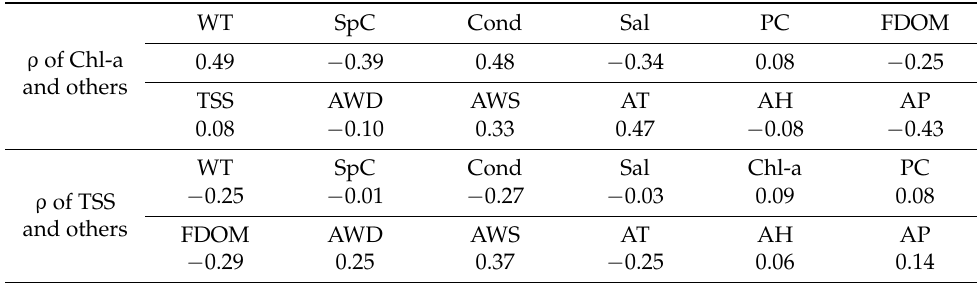
Table 1. Correlation analysis of the available variables WT, SpC, Cond, Sal, PC, FDOM, AWD, AWS, AT, AH, and AP in all-valid